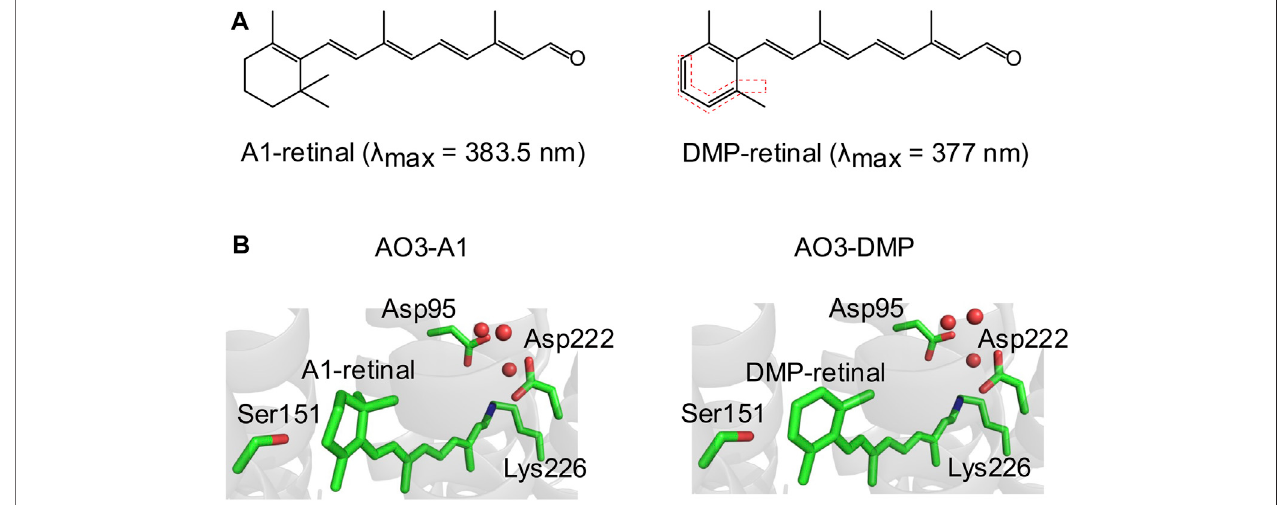
FIGURE1| StructuresofA1-retinalanditssynthesizeddimethylphenylatedretinalderivative(DMP-retinal). (A) Chemicalstructuresofthenaturalchromophoreall- trans A1-retinal (left) and its dimethyl phenylated derivative (DMP-retinal) (right) . The bonds highlighted by the red dotted lines indicate the modi fi ed groups. The absorption maxima ( λ max ) of A1-retinal and DMP-retinal in ethanol are shown in parentheses. (B) The QM/MM optimized structural environment of AO3 around the chromophore, A1-retinal (left) and DMP-retinal (right) . Red circles indicate water molecules.